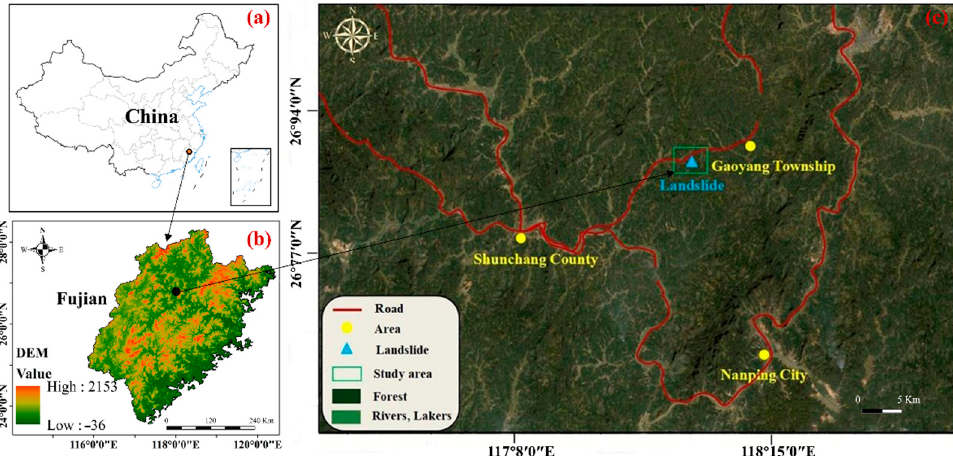
Figure 2. Location map of the Nanping road slope. ( a ) The location of Fujian in the whole country; ( b ) Nanping terrain; ( c ) The location of slope.